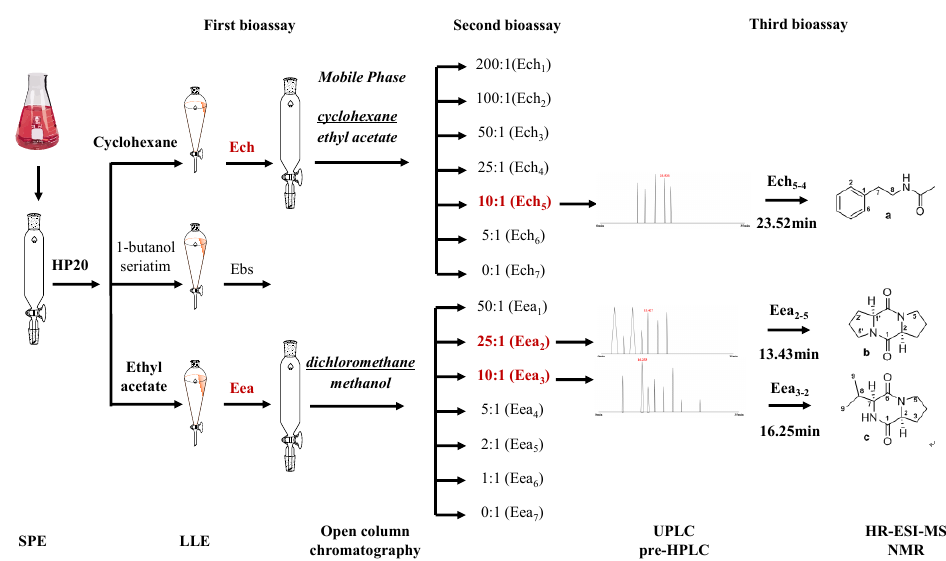
Figure 1. Isolation and bioassay program for potential allelopathic compounds from crude extraction of cell-free filtrate of Bacillus cereus BE23.